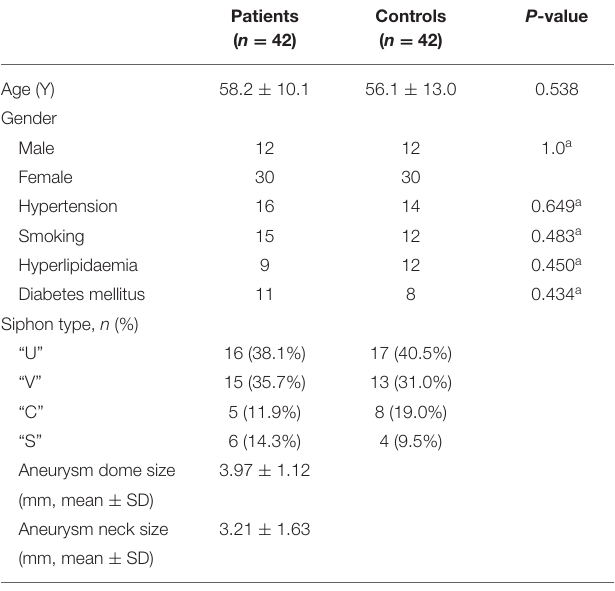
TABLE 1 | Comparison of patients with paraclinoid aneurysms with the age- and sex-matched control group. Patients ( n =